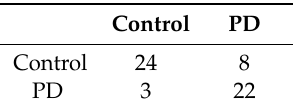
Table 1. Confusion table obtained by linear discriminant analysis (LDA) using the fourth principal component (PC) loading obtained by principal component analysis (PCA) using 255 mRNAs identified by PCA-based unsupervised feature extraction (FE). Rows: true, columns: prediction.